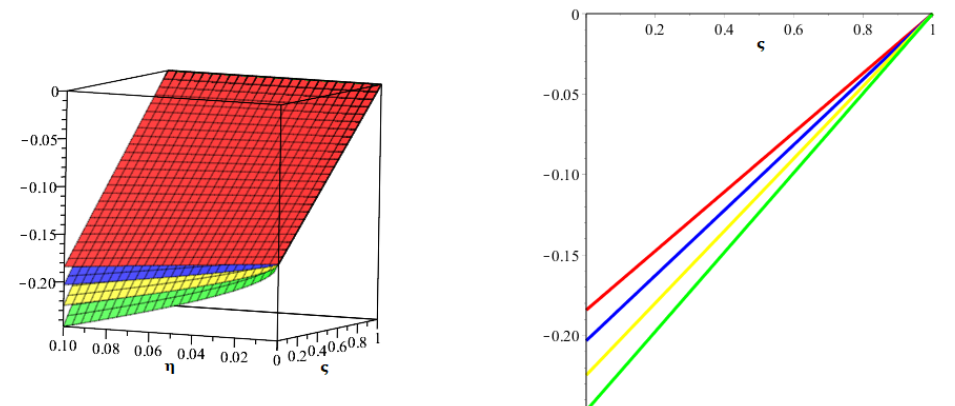
Figure 6. The proposed method solution at different values of γ for example